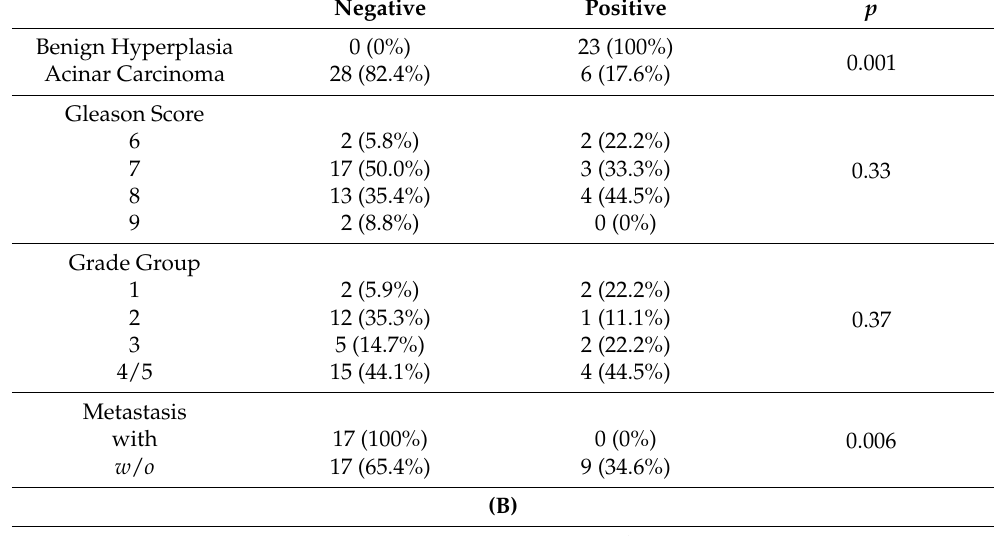
Table 2. (A) Evaluation of ZNF750 cytoplasmatic staining in normal prostate and prostatic acinar adenocarcinomas of patients with and without metastasis. (B) Evaluation of ZNF750 nuclear staining in normal prostate and prostatic acinar adenocarcinomas of patients with and without metastasis. (A) ZNF750 Cytoplasmatic